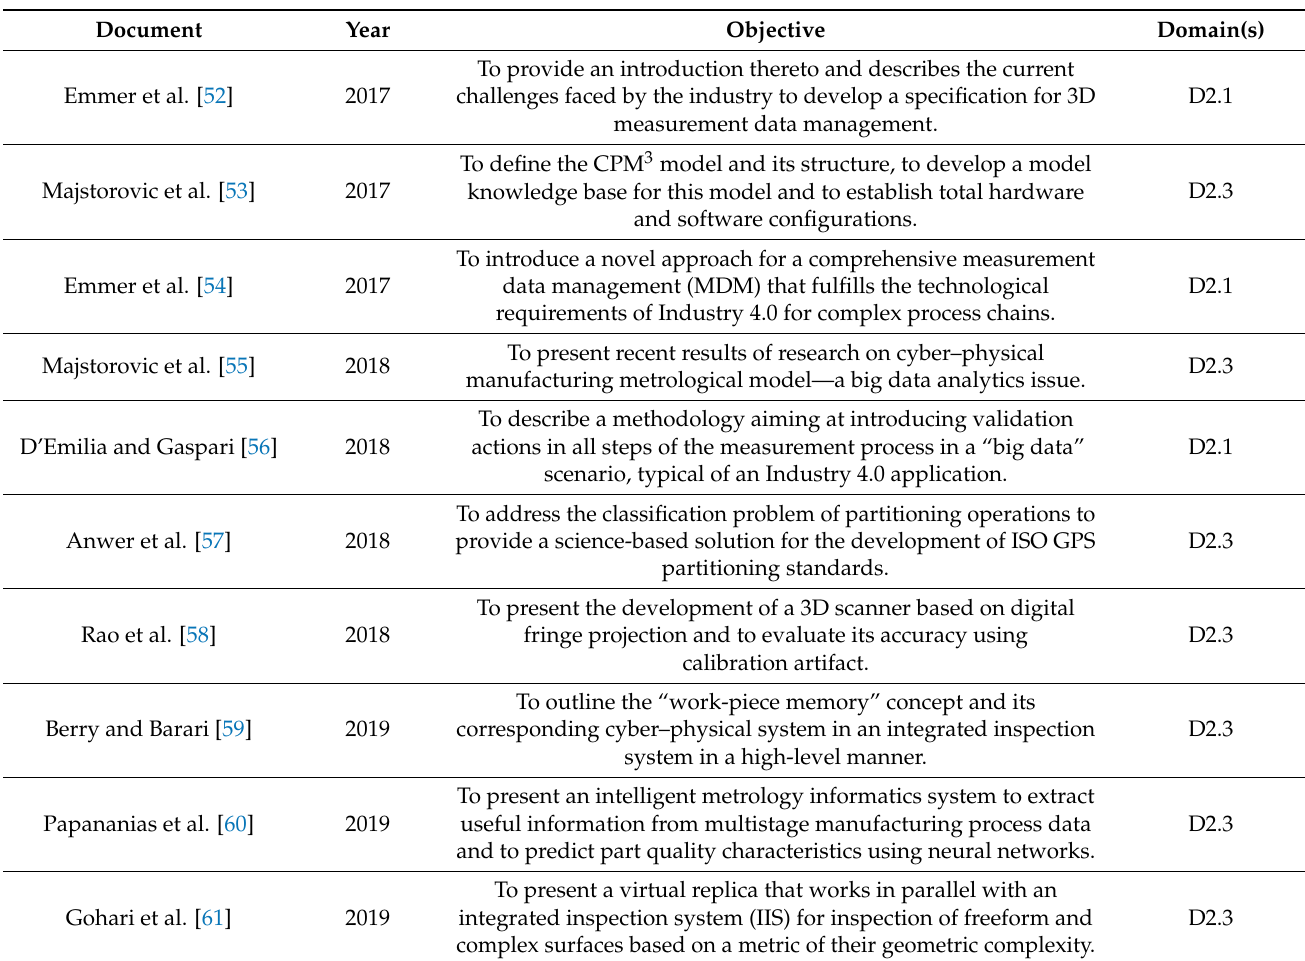
Table 5. Documents reviewed in the “Metrology in the Analysis of Large Amounts of Data”